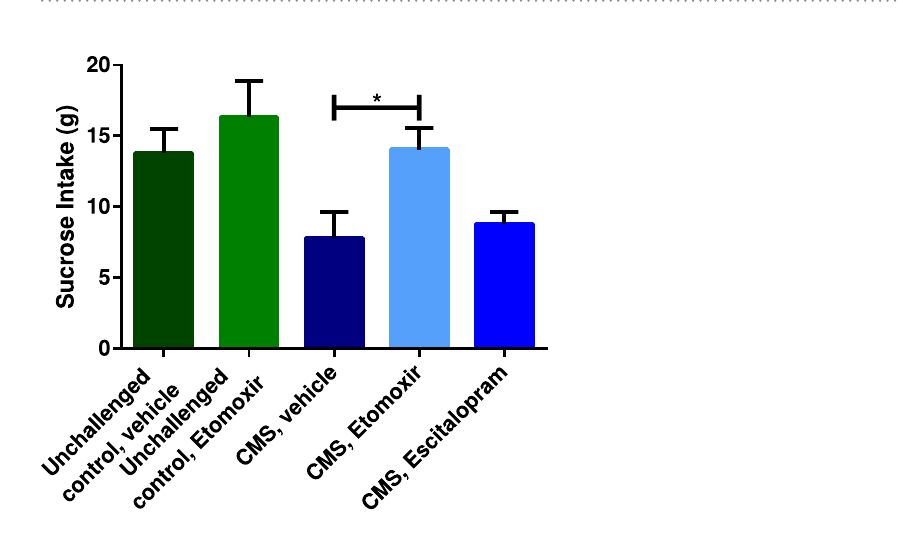
Figure 2. Treatment efficacy in the different groups after five weeks of drug treatment. All data are presented as mean ± SEM. The results from the one-way ANOVA (F = 4.178, DF = 4, p = 0.0052) with a Tukey multiple comparisons post hoc test showed statistical significance between CMS exposed animals receiving vehicle and Etomoxir. Number of asterisks indicates level of statistical significance ( * p = 0.01–0.05).